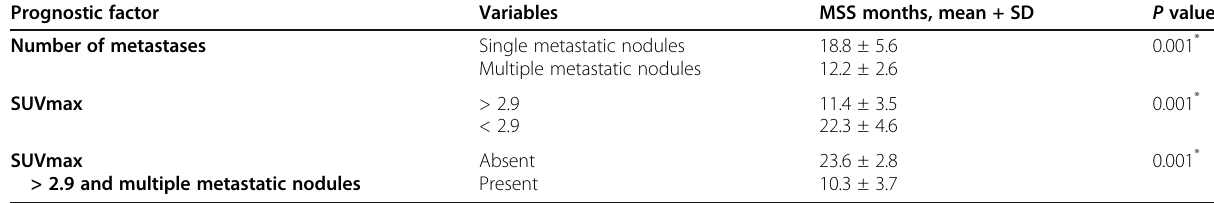
Table 9 Melanoma-specific survival of patients with metastases and maximum standardized uptake value Prognostic